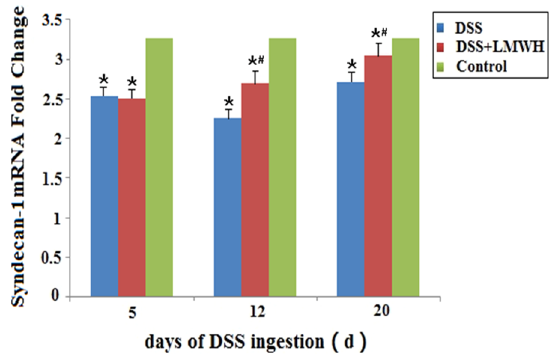
Figure 3. mRNA expression of syndecan-1 in the intestinal mucosa. The mRNA level of syndecan-1 in the intestinal mucosa was evaluated by qRT-PCR on the indicated day respectively. (n=18/group). * P , 0.05 vs. the control; # P , 0.05 vs. the DSS